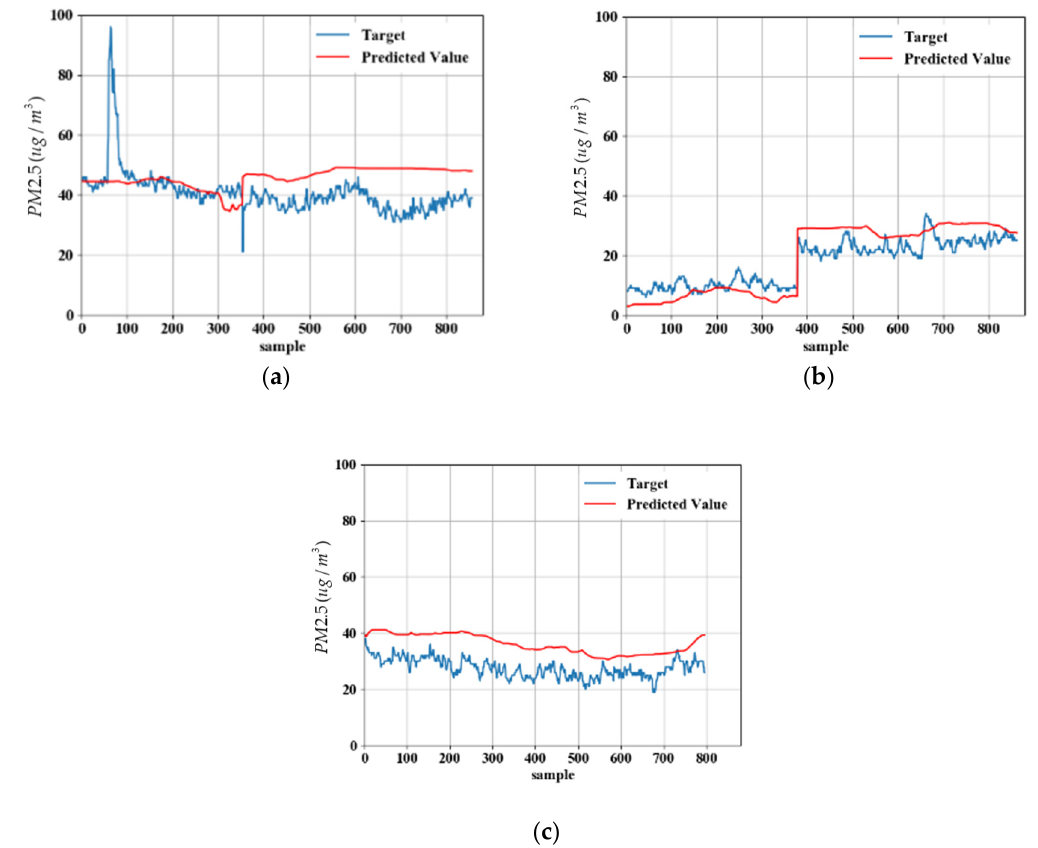
Figure 20. Prediction results of the multilayer perceptron model: model prediction results for ( a ) 15 February, ( b ) 28 February, and ( c ) 1 March 2019.